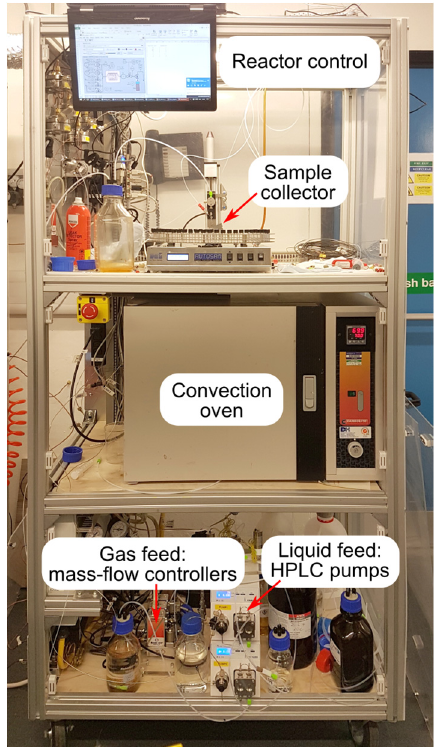
Figure 11. Photograph of the hydrogenation reactor system used in the current study.